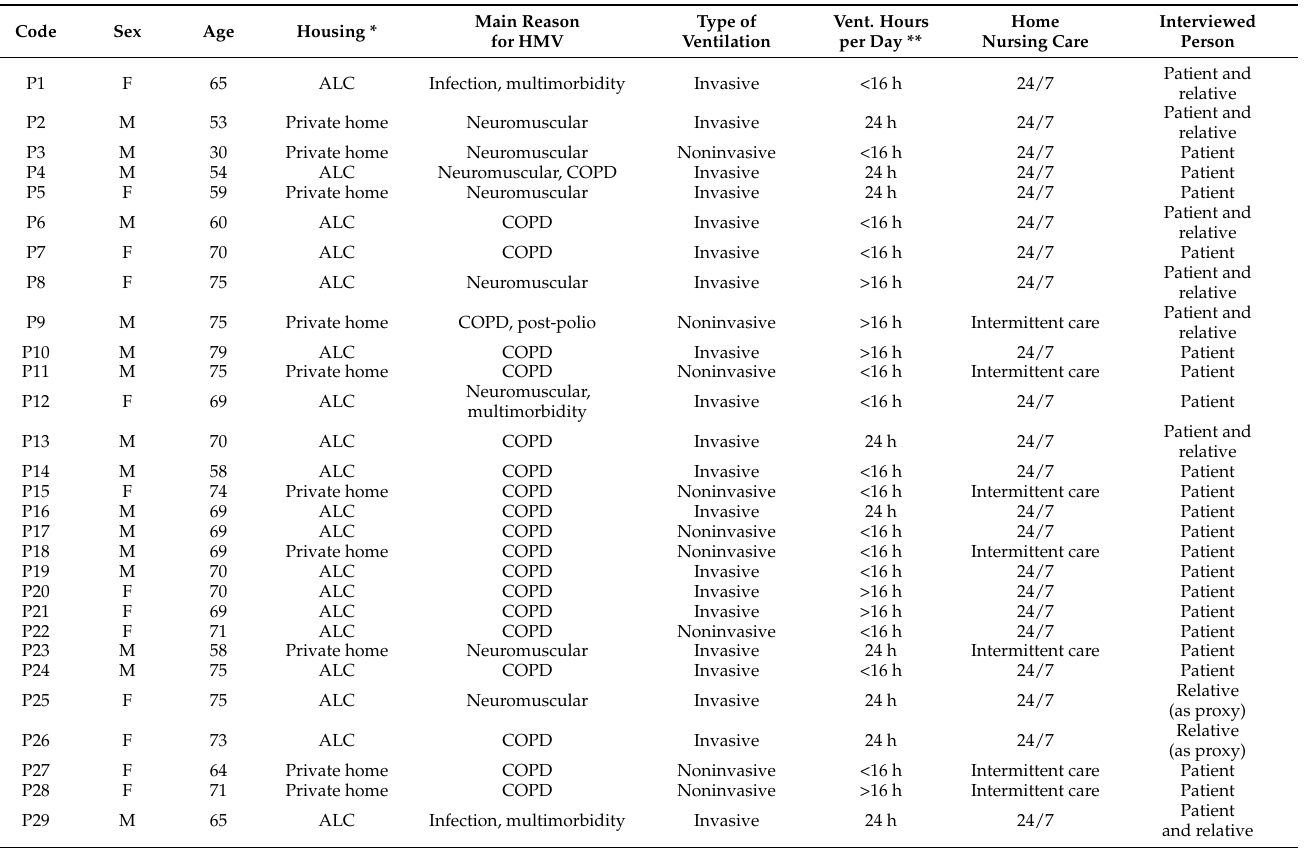
Table 1. Patients’ sociodemographic, disease-specific, and treatment-related